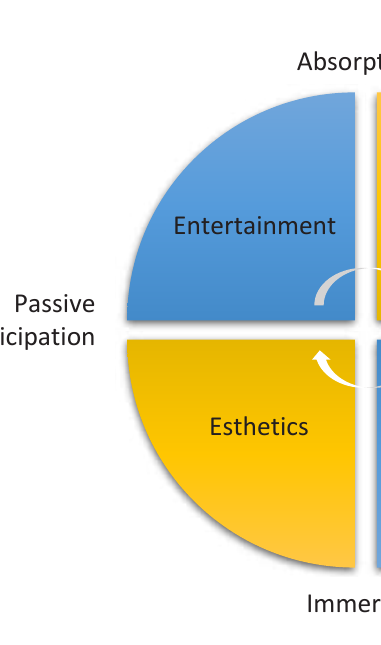
Figure 1. The four realms of experience